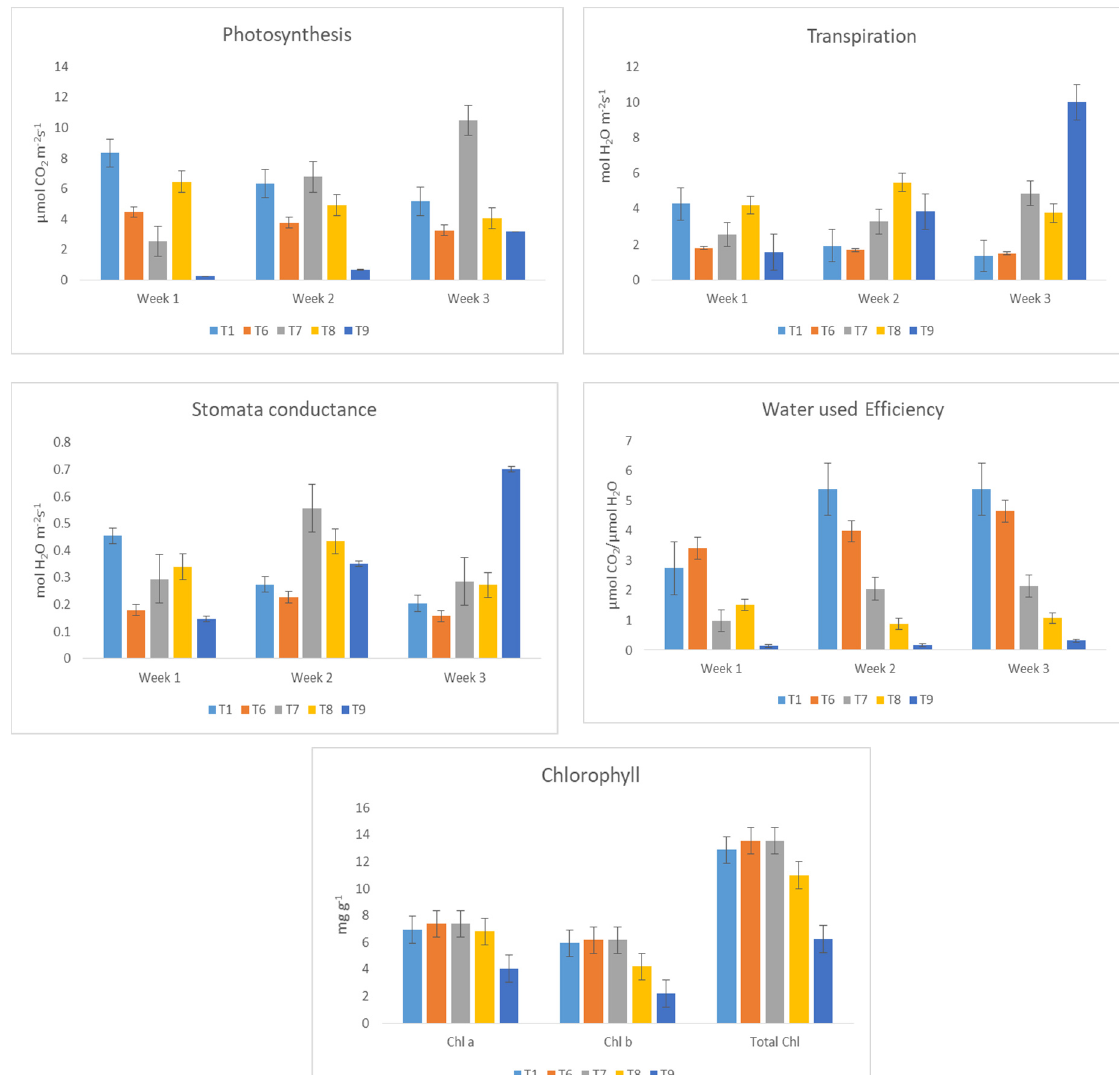
Figure 8. The physiological responses for T1, T6, T7, T8, and